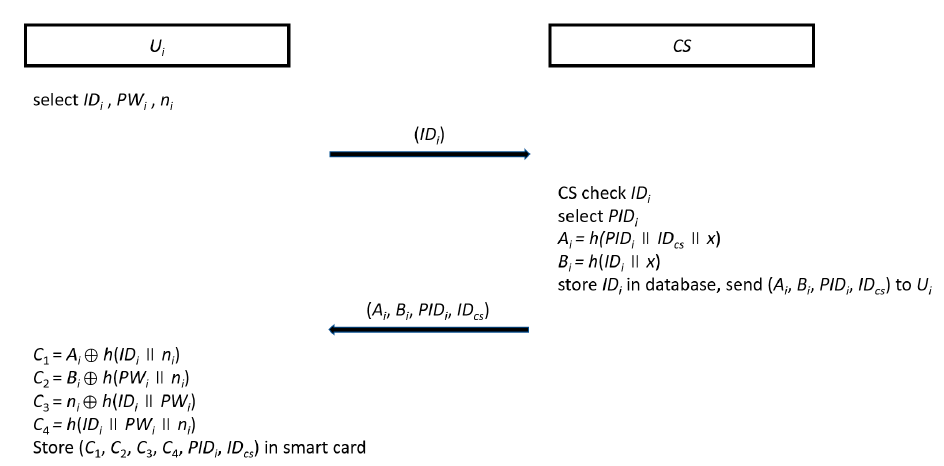
Figure 1. The flowchart of the user registration phase.